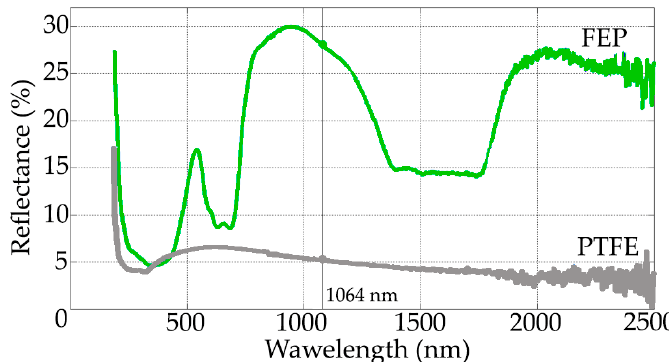
Figure 5. The reflectance (%) at 1064 nm presented in the FEP (up) and PTFE (down) coatings.